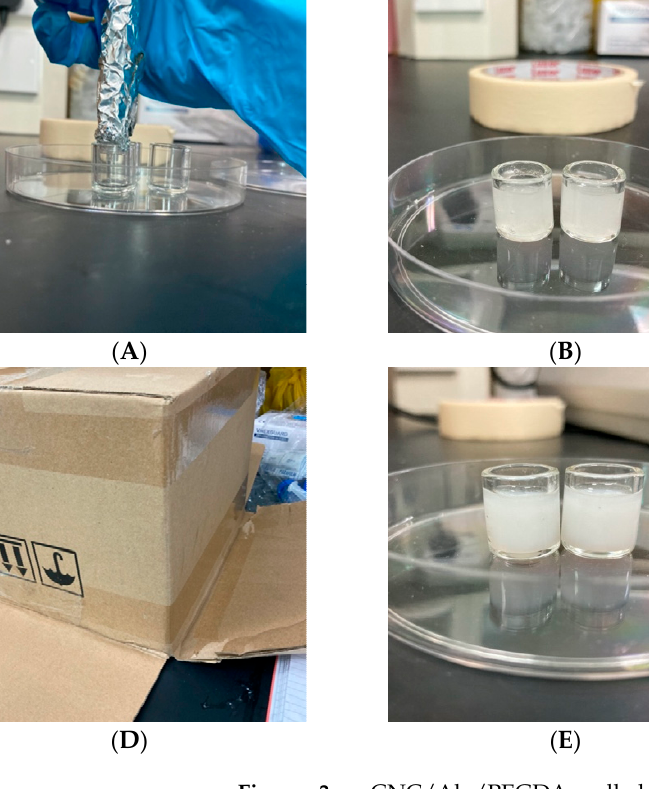
Figure 3. CNC/Alg/PEGDA gelled formulation extruded into glass mould ( A ), gelled CNC/Alg/PEGDA formulation in glass mould ( B ), UV irradiation using portable UV lamp with 365 nm ( C ), UV irradiation process carried out covered with a box ( D ), and CNC/Alg/PEGDA constructs post UV irradiation ( E